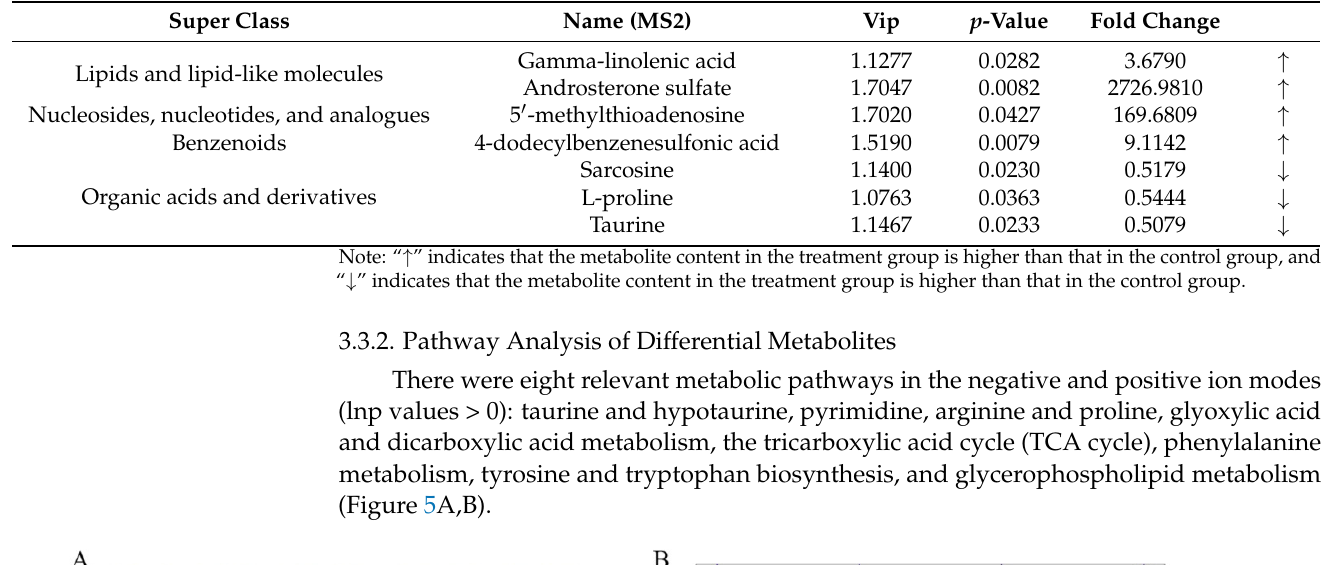
Table 3. The difference in metabolites in the negative ion mode.